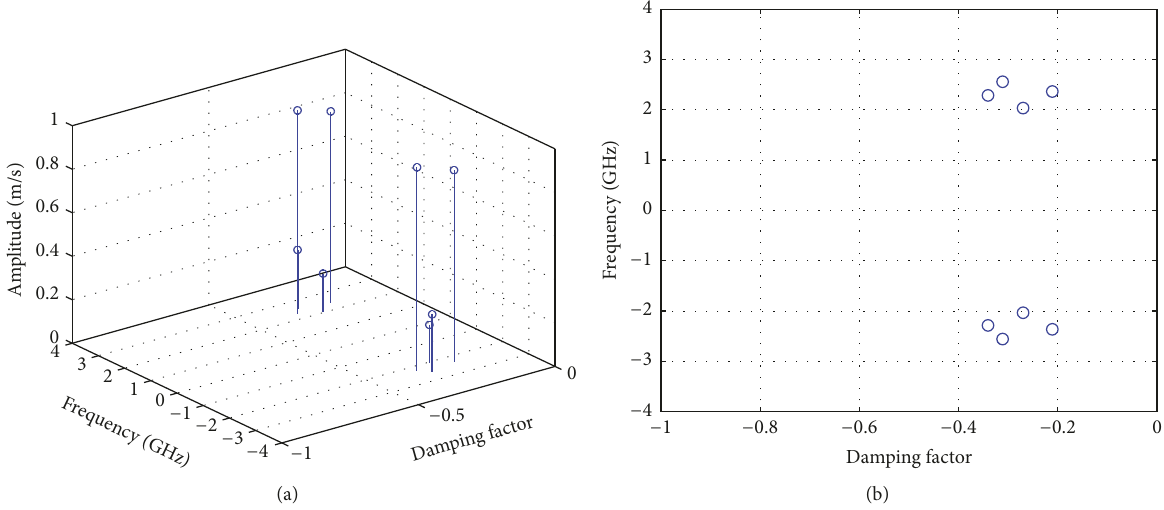
Figure 19: Using classical MP method: (a) pole-residue relationship and (b) frequency versus damping factor of microstrip antenna.